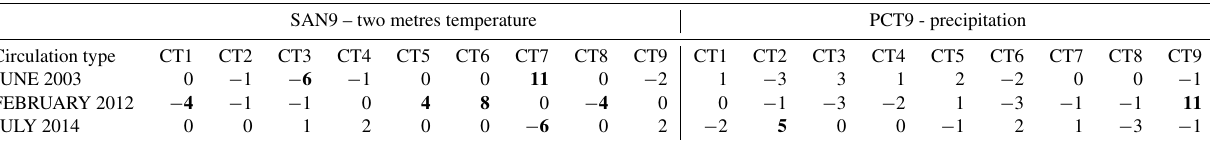
Table 1. Frequency climatological anomaly for the 3 case studies. Those anomalies with an occurrence of greater than four days per month are shown in